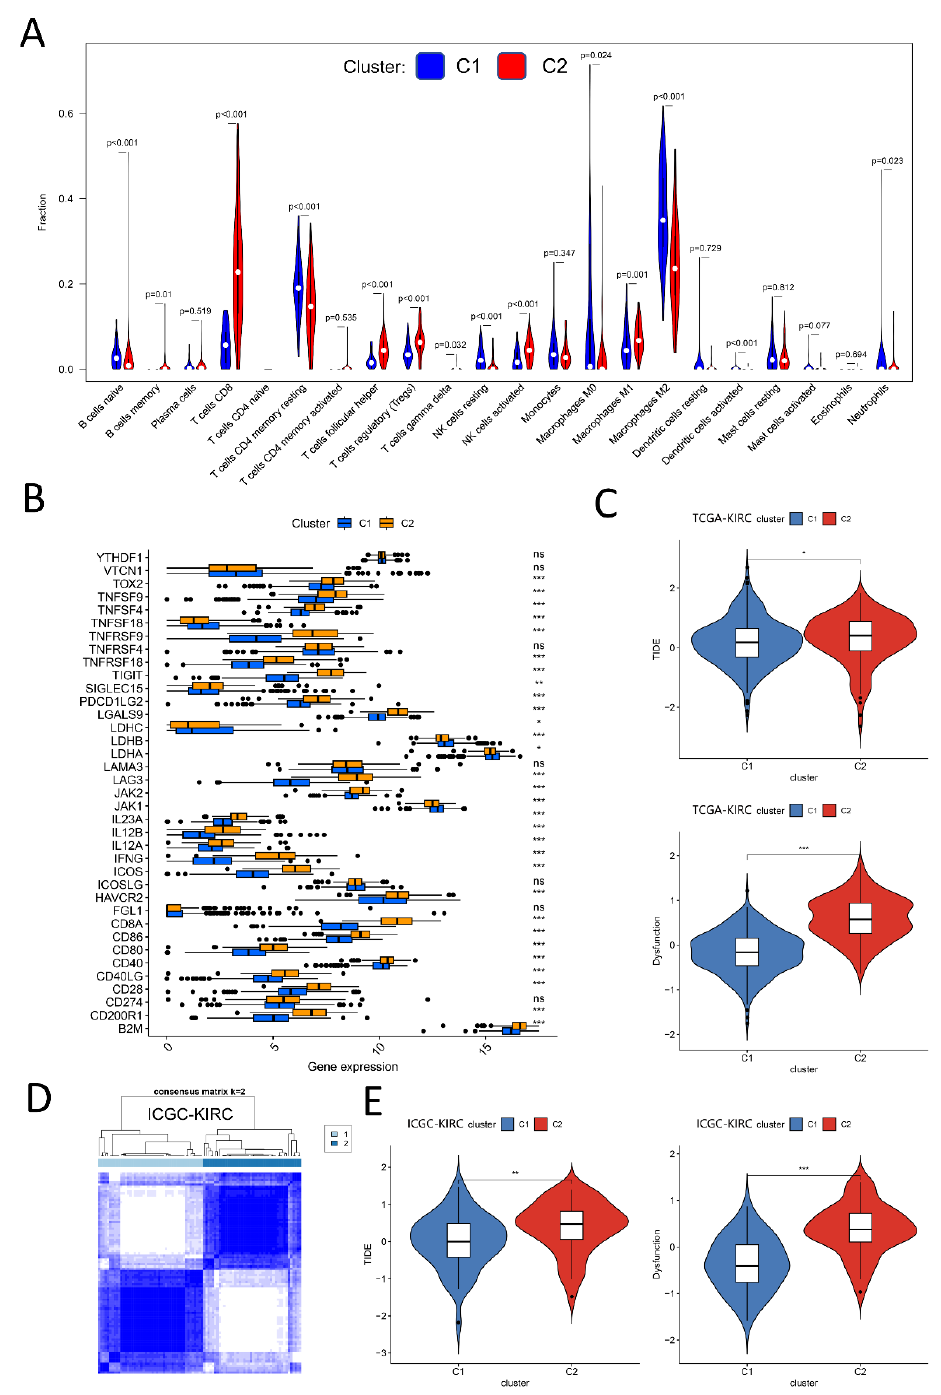
Figure 4. Distinct immune characteristics between two clusters. ( A ): The difference of 22 types of immune cell infiltration between cluster 1 and cluster 2. ( B ): Distribution difference of 39 immune checkpoint genes between two clusters. ( C ): Difference of tumor immune dysfunction and exclusion (TIDE) score and dysfunction score between two clusters in TCGA-KIRC cohort. The lower the scores of TIDE and dysfunction, the more likely patients are to benefit from immunotherapy. ( D , E ): Consis- tent clustering in (ICGC-KIRC) cohort to get two clusters with different TIDE and dysfunction scores. (ns, not significant; * represents p < 0.05; ** denotes p < 0.01; *** means p <